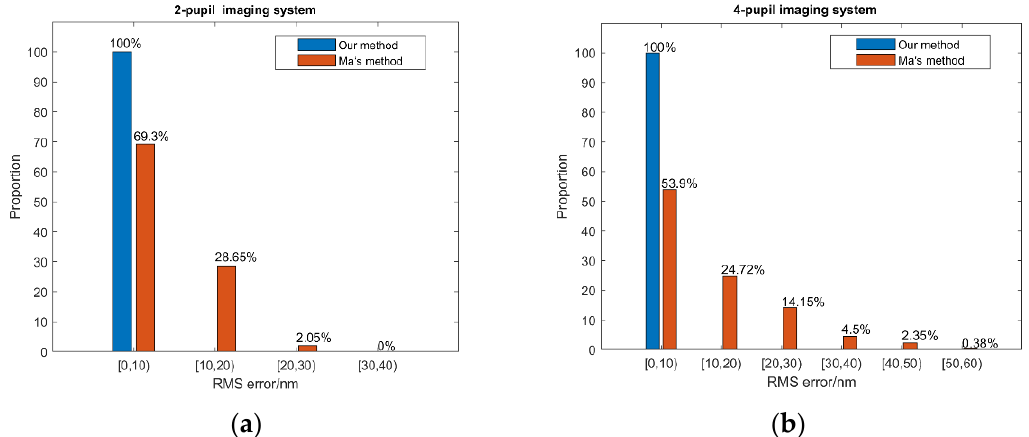
Figure 14. The piston error detection accuracy comparison between our method and Ma’s method ( a ) for the 2-pupil imaging system and ( b ) the 4-pupil imaging system.